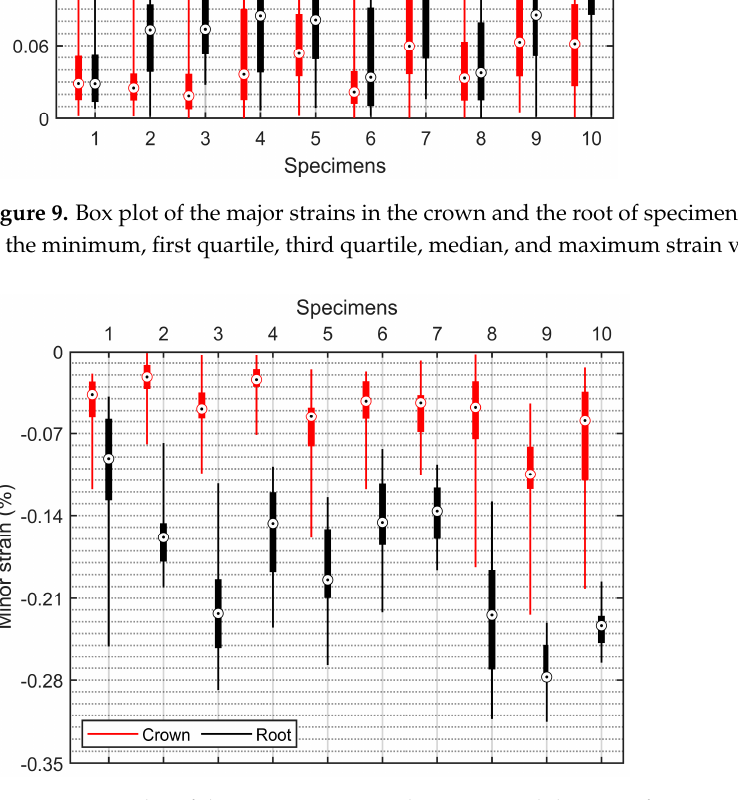
Figure 10. Box plot of the minor strains in the crown and the root of specimens. The composition of the boxes is the same as described in Figure 9. Table 1. Statistical analysis of strains between the crown and the root of specimens.